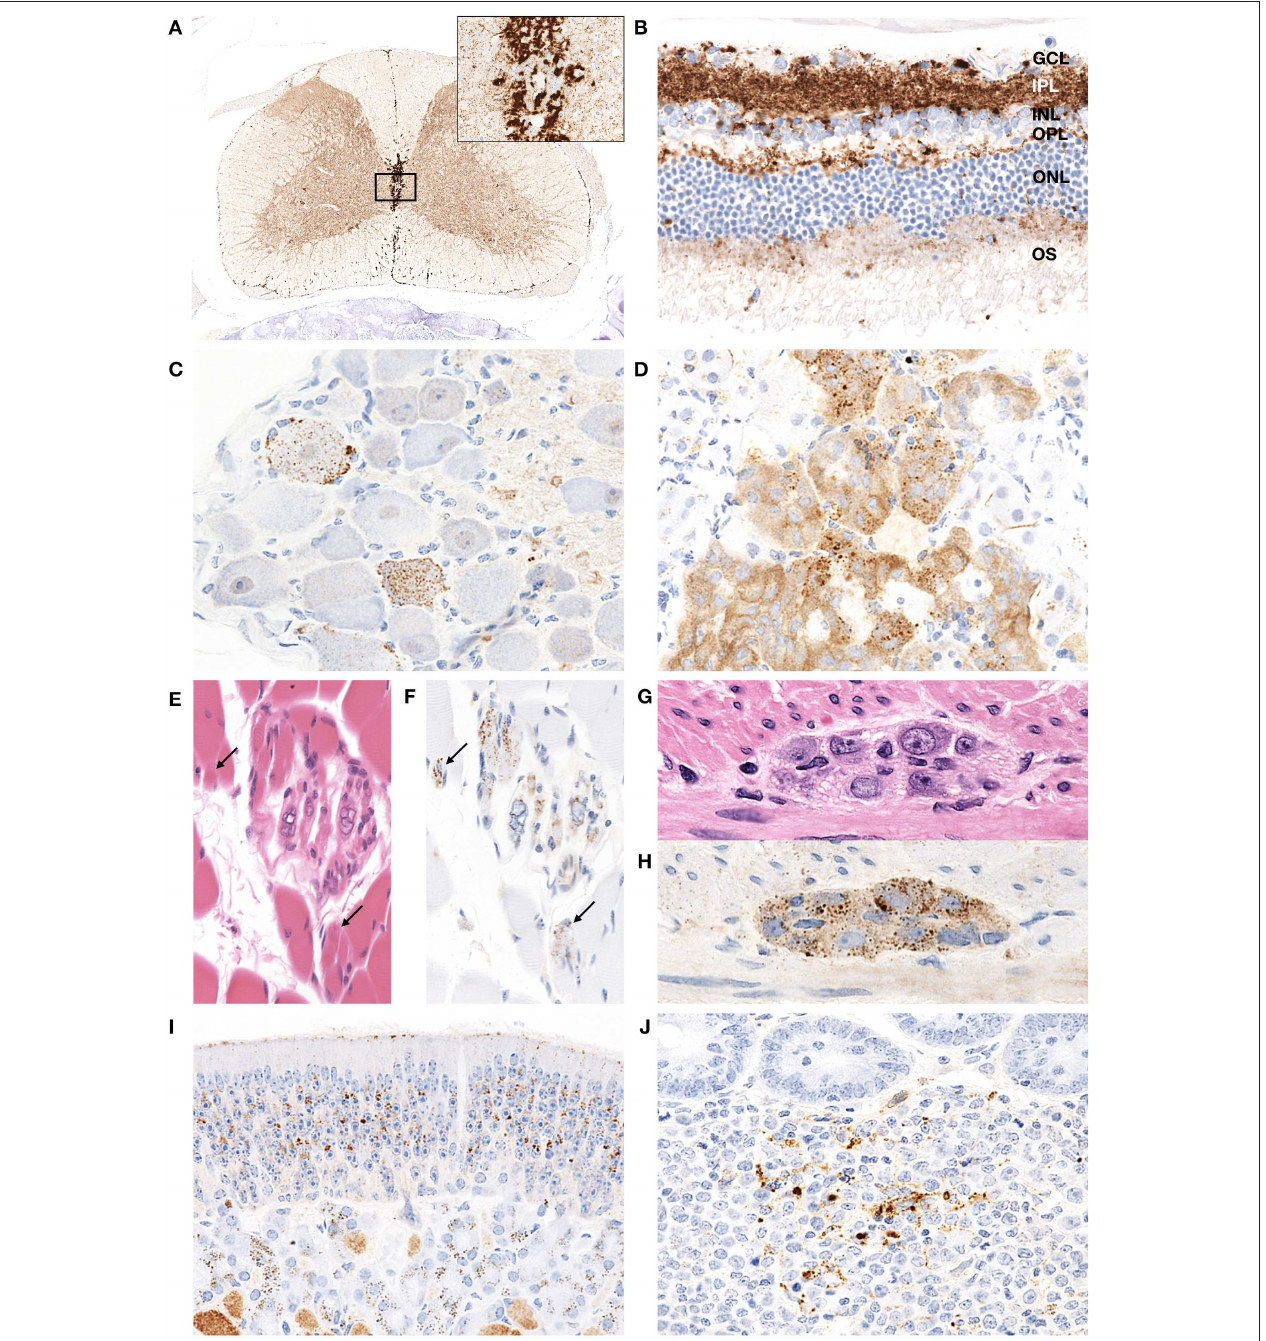
FIGURE 6 | PrP d distribution in extracerebral tissues of H-BSE-infected hamsters. Dense PrP d aggregates are observed in the peri-central canal and subpial regions, and granular PrP d deposits are conspicuous in the gray matter (A) . The area within the box is shown enlarged in the inset in the upper right corner. Diffuse granular deposition of PrP d is observed in all layers of the retina (B) . GCL, ganglion cell layer; INL, inner nucleus layer; IPL, inner plexiform layer; NFL, nerve fiber layer; ONL, outer nucleus layer; OPL, outer plexiform layer; OS, outer segments. Granular PrP d deposits are observed in the ganglionic and satellite cells of the trigeminal ganglion (C) , chromaffin cells of the adrenal medulla (D) , intrafusal myofiber of the muscle spindle (E,F) , skeletal muscle fibers ( E,F ; arrows), and neuronal cells of the myenteric plexus in the colon (G,H) . PrP d deposits are observed in the olfactory sensory epithelium of the nasal mucosa (I) and the Peyer’s patch, presumably corresponding to follicular dendritic cells (J) . Immunohistochemistry was performed with mAb 44B1.